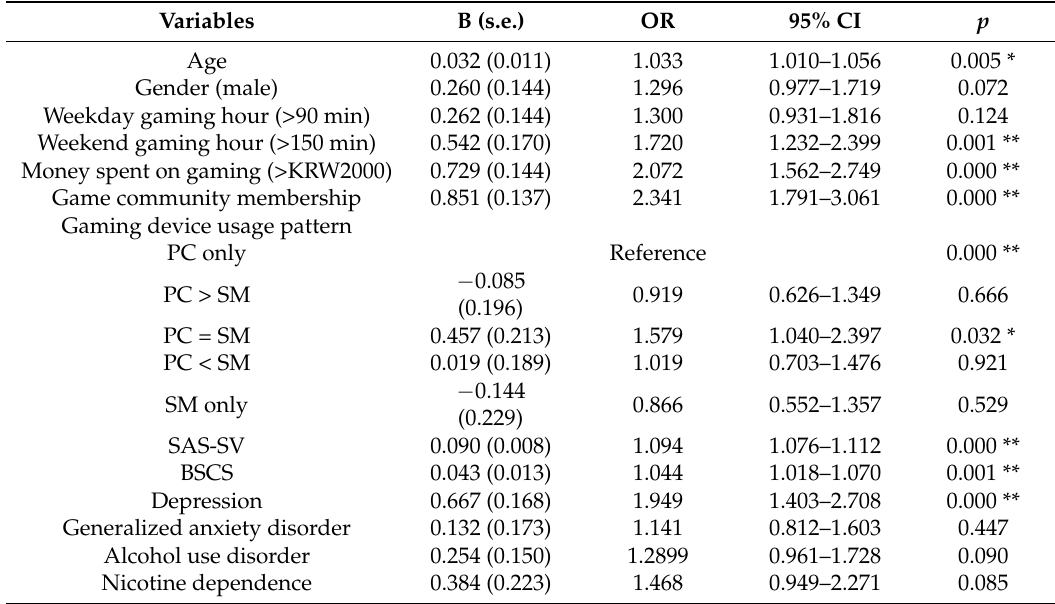
Table 3. Logistic regression results predicting Internet gaming